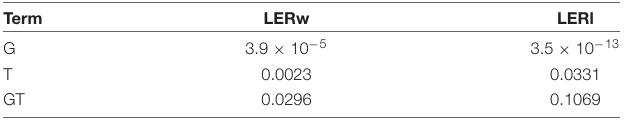
TABLE 6 | p -Values of Fisher test on wheat genotype (G), legume tester variety (T) main effects and their interaction (GT) from an ANOVA analysis.